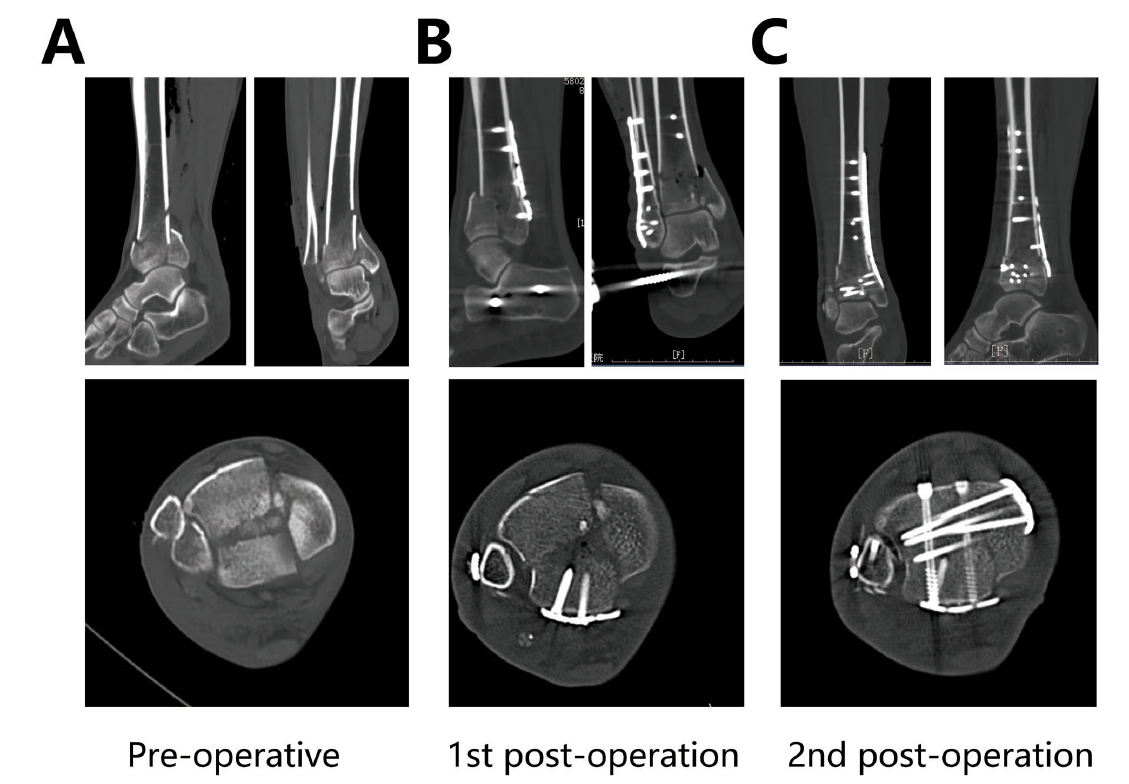
Figure 4. CT images of the patient ( A ) after the fracture ( B ) after the first surgery ( C ) after the second surgery.